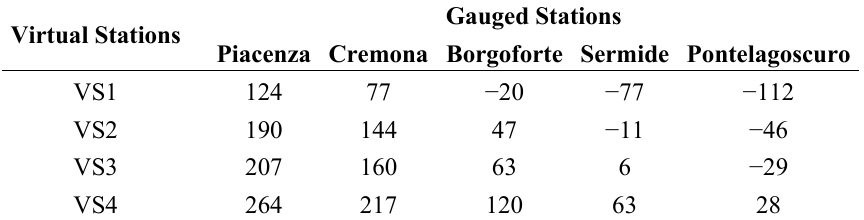
Table 2. Distance in km between in situ gauged stations and virtual stations, VSs. Negative (positive) distances indicate that the track crosses the river upstream (downstream) from the gauged